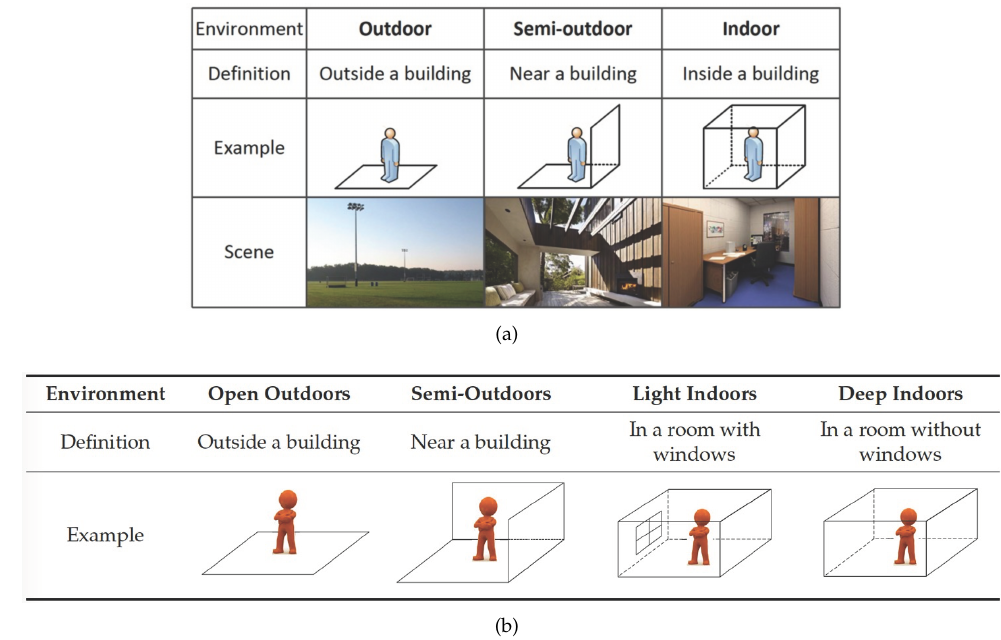
Figure 3. Space classification and definitions by concerning sensor reception. ( a ) Space classification based on building [15]. ( b ) Space definition according to the reception of satellites signal [18].